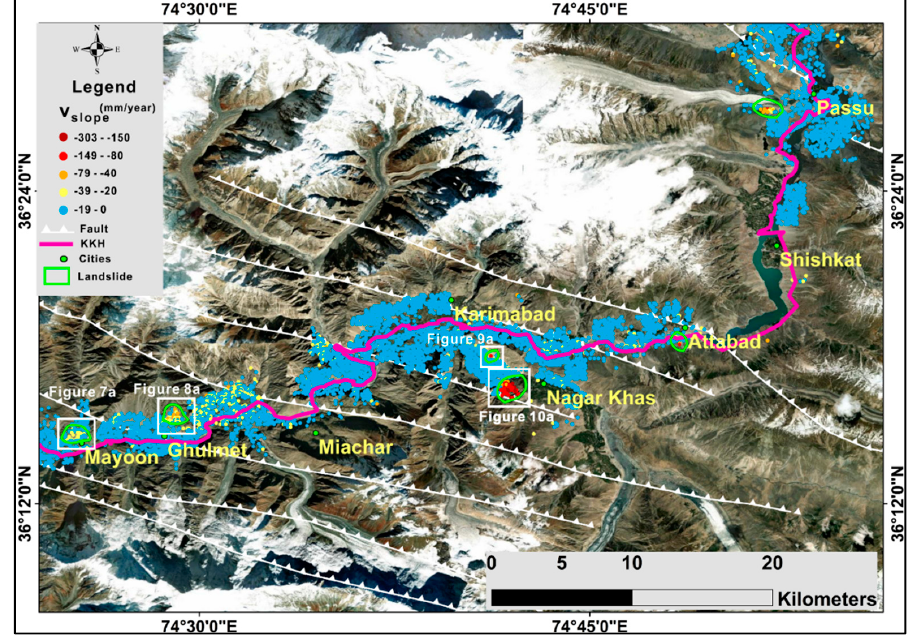
Figure 6. The average velocity in V slope from February 2017 to August 2019 plotted in Google Earth over a part of Hunza-Nagar region. The green polygons represent the CTs cluster exceeding threshold velocity.